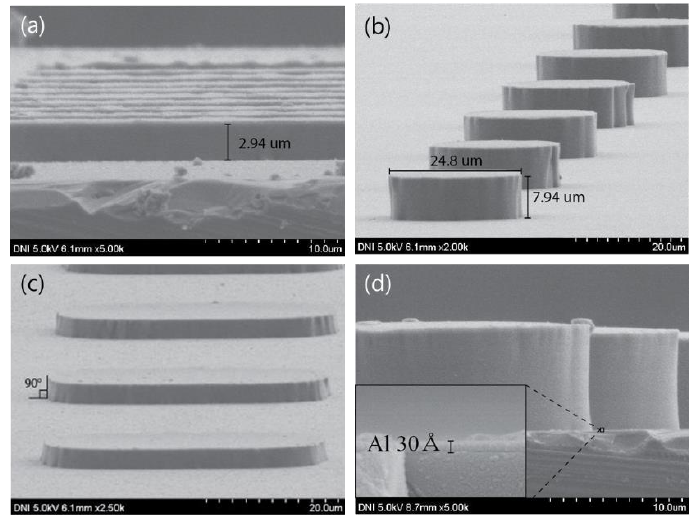
Figure 4. ( a ) PDMS on Si substrate, ( b ) surface of PDMS membrane, ( c ) and ( d ) dry etched PDMS on Al substrate.